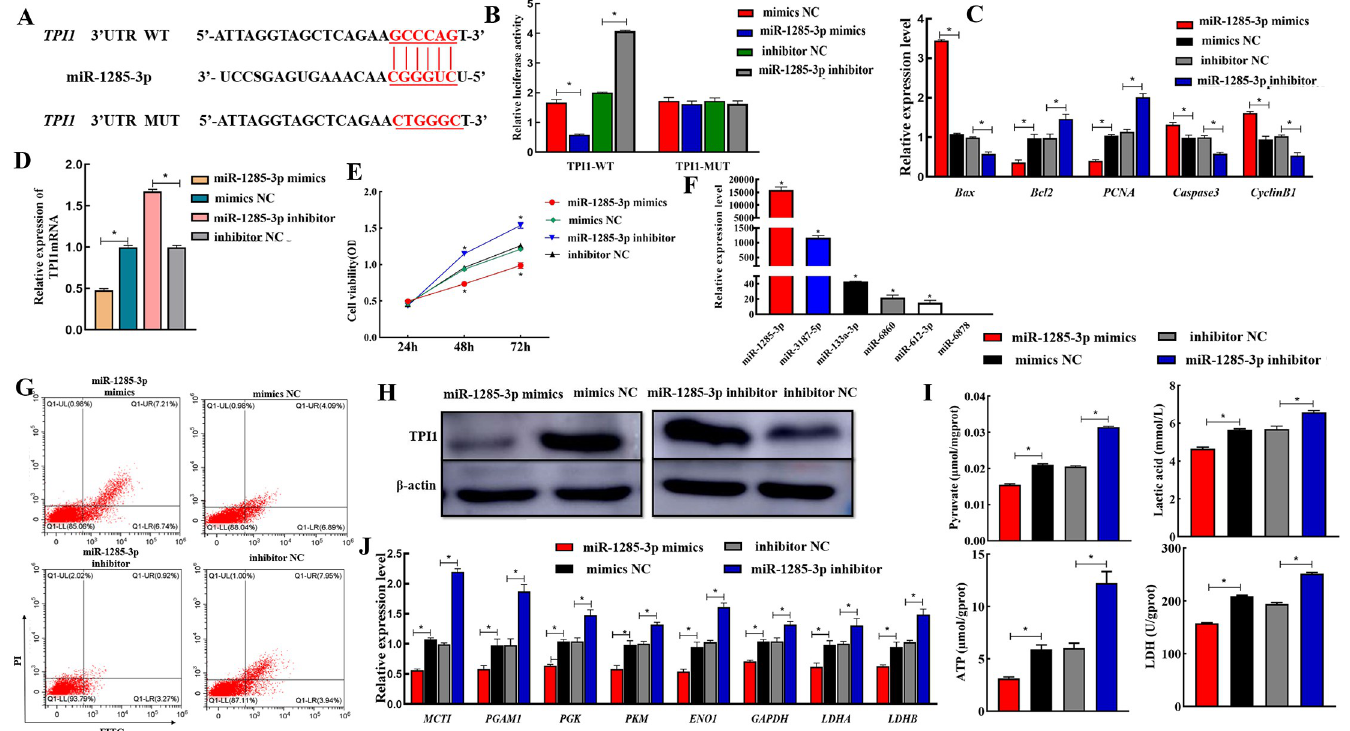
Fig 6. TPI1 expression is downregulated by miR-1285-3p directly targeting of the 3’-UTR of TPI1. A, TPI1 was found for the potential regulatory targets of miR- 1285-3p using prediction tool. B, Dual-luciferase reporter assay analysis of the target relationship of miR-1285-3p with TPI1. F, Expression of miRNA in SCs. The TPI1 expression levels were determined by real-time PCR analysis (D) western blot (H) after transfection with the miR-1285-3p mimics or negative control or after transfection with the miR-1285-3p inhibitor or negative control in SCs. CCK-8 (E), Flow cytometry (G) and the expression of proliferation, cycle and apoptosis related genes (C) was used to detect the apoptosis of SCs after transfection miR-1285-3p mimics, negative control, miR-1285-3p inhibitor or negative control. The expression levels of downstream genes (J) and the content of glycolytic metabolic pathway products, energy and key enzymes (I) of SCs after transfection miR-1285-3p mimics, negative control, miR-1285-3p inhibitor or negative